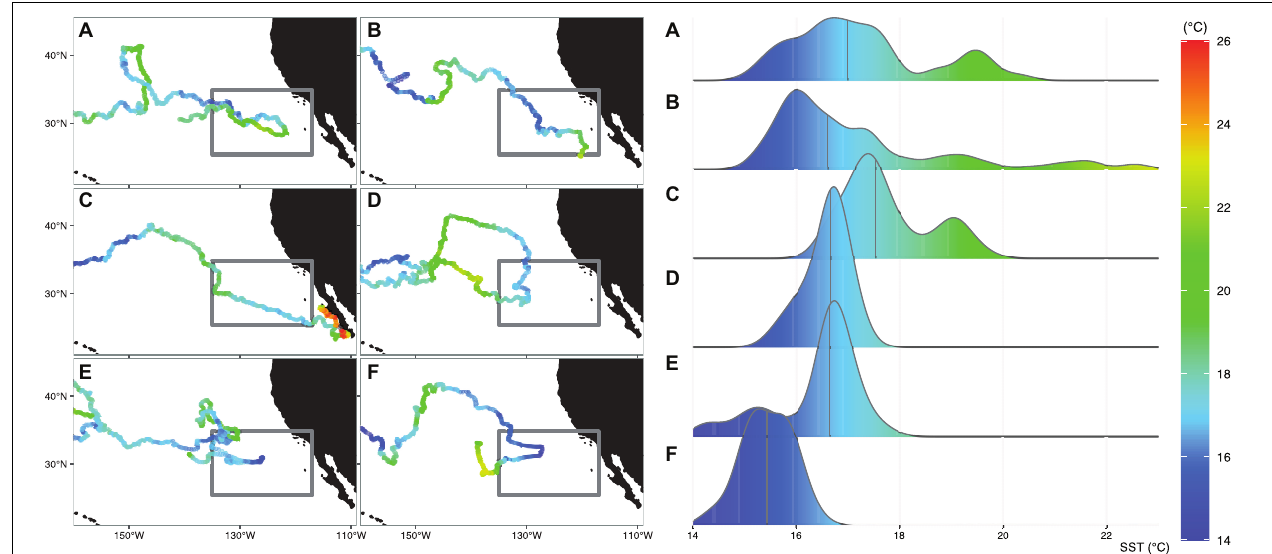
FIGURE 2 | Left panel: Daily sea surface temperatures (SST) extracted under the 6 satellite-tracked individuals that moved into the eastern North Pacific study region (gray box). Turtles (A,D–F) did not complete migration to the North American coast, but instead reversed direction and moved towards the Central North Pacific. Turtles (B,C) successfully moved through the study region in an eastward direction. Right panel: Density distribution of the corresponding daily SSTs experienced by each turtle upon entering the study region and until reaching the location of maximum eastward longitude. Vertical line represents the median SST value.